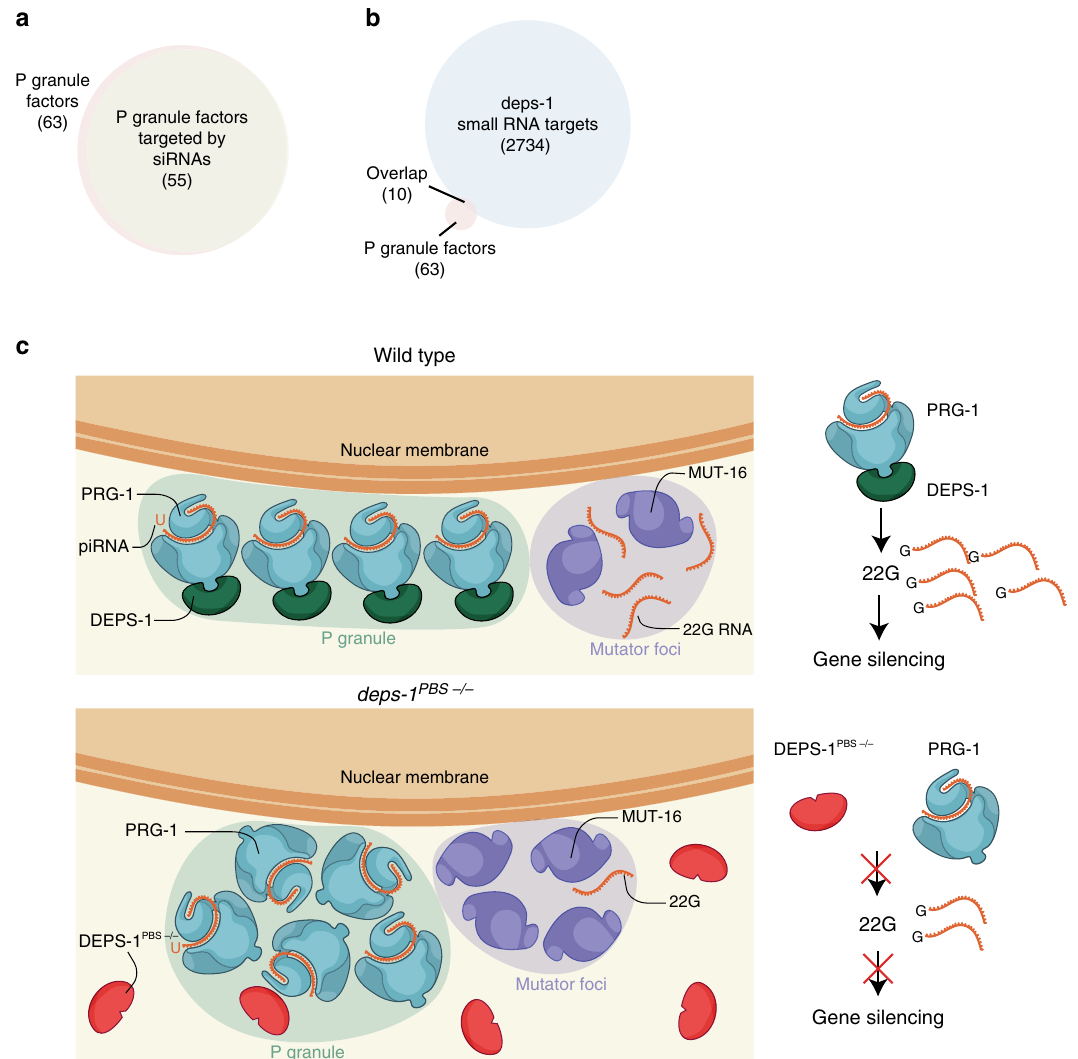
Fig. 5 P granule components are targeted by small RNAs and mechanistic model of DEPS-1 function in small RNA pathways. a 55 P granule factors are targeted by endo-siRNAs. b The 22Gs of 10P granule factors are differentially regulated in deps-1(bn121) mutant. c Wild-type DEPS-1 binds directly to the PIWI domain of PRG-1 via the PBS motif in the N-terminal. The PRG-1 and DEPS-1 clusters interact to form elongated perinuclear condensates. Intact PRG- 1/DEPS-1 complex maintains normal morphology of PRG-1 and MUT-16 condensates. Ef fi cient gene silencing mediated by the piRNA pathway ensues